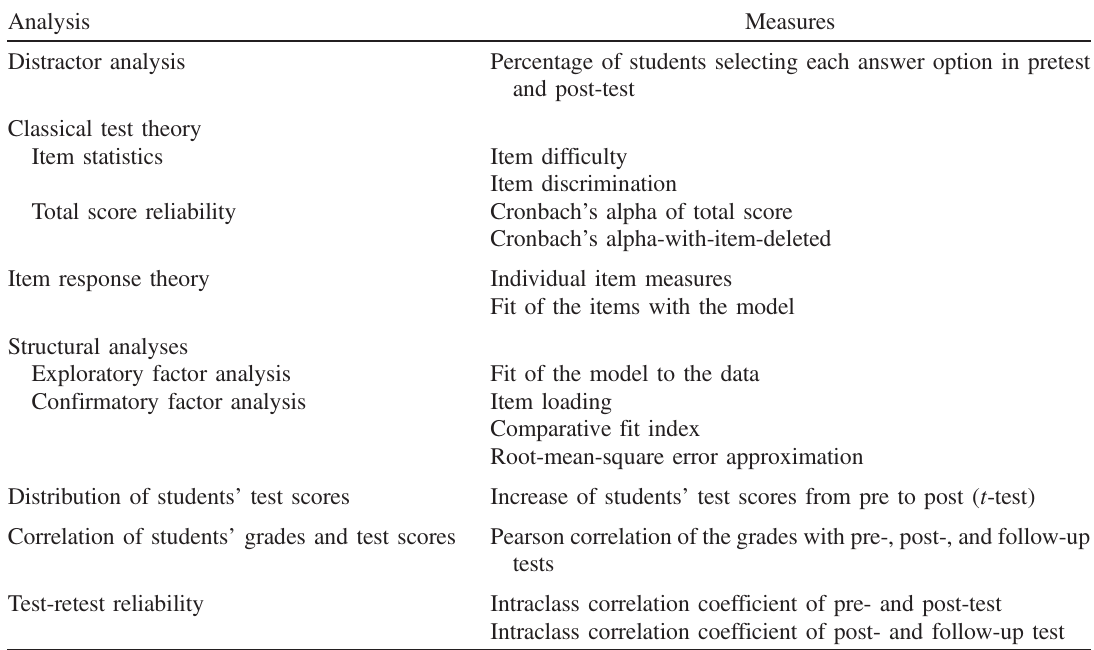
TABLE III. Summary of analyses conducted for quantitative test analyses of the ROC-CI.